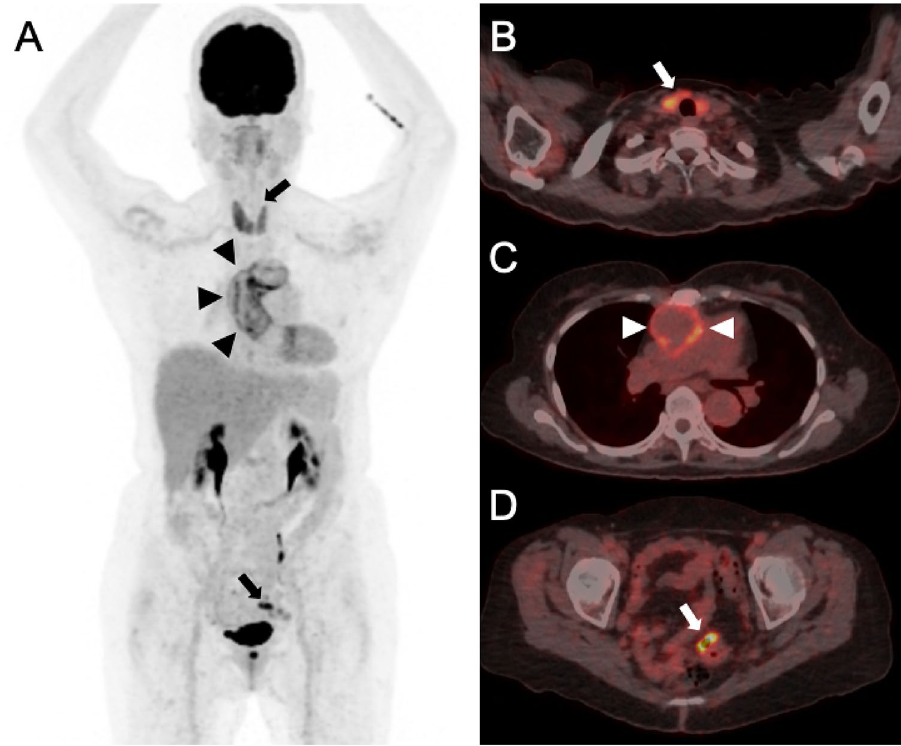
could be stopped. PET/CT [maximum intensity reconstructions of PET ( A ) and fused PET/CT images ( B – D )] showed diffuse FDG uptake along the ascendens graft (Index surgery: aortic arch replacement